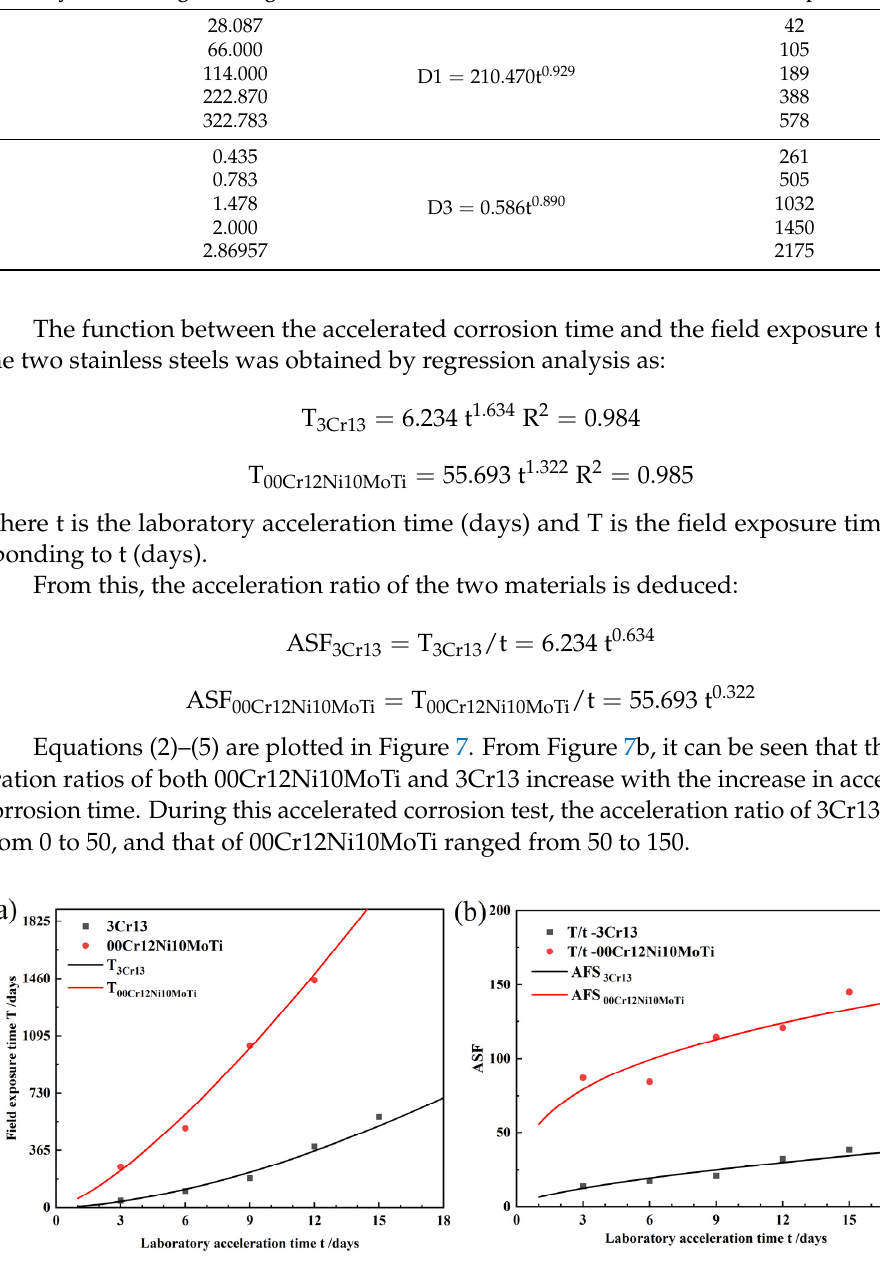
Figure 7. Acceleration ratio analysis: ( a ) relationship between laboratory-accelerated corrosion time and field exposure time, ( b ) acceleration ratio.